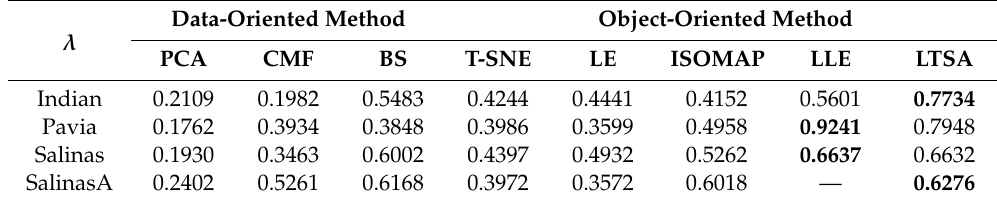
Table 4. Separability between classes ( λ